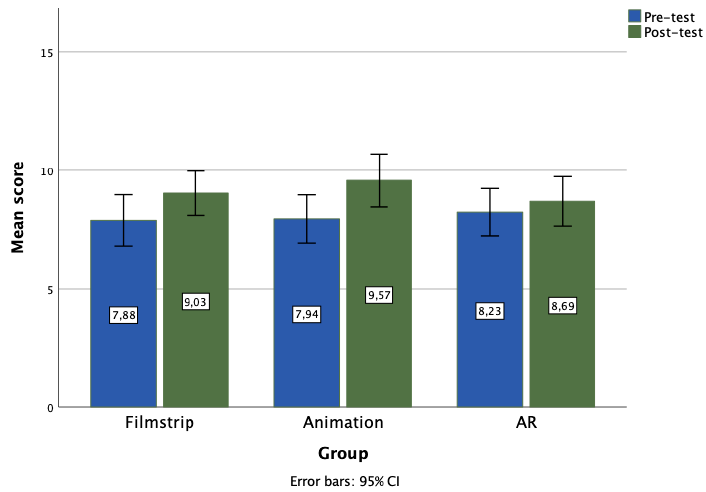
Figure 4. Mean scores in domain-specific knowledge for the different groups.